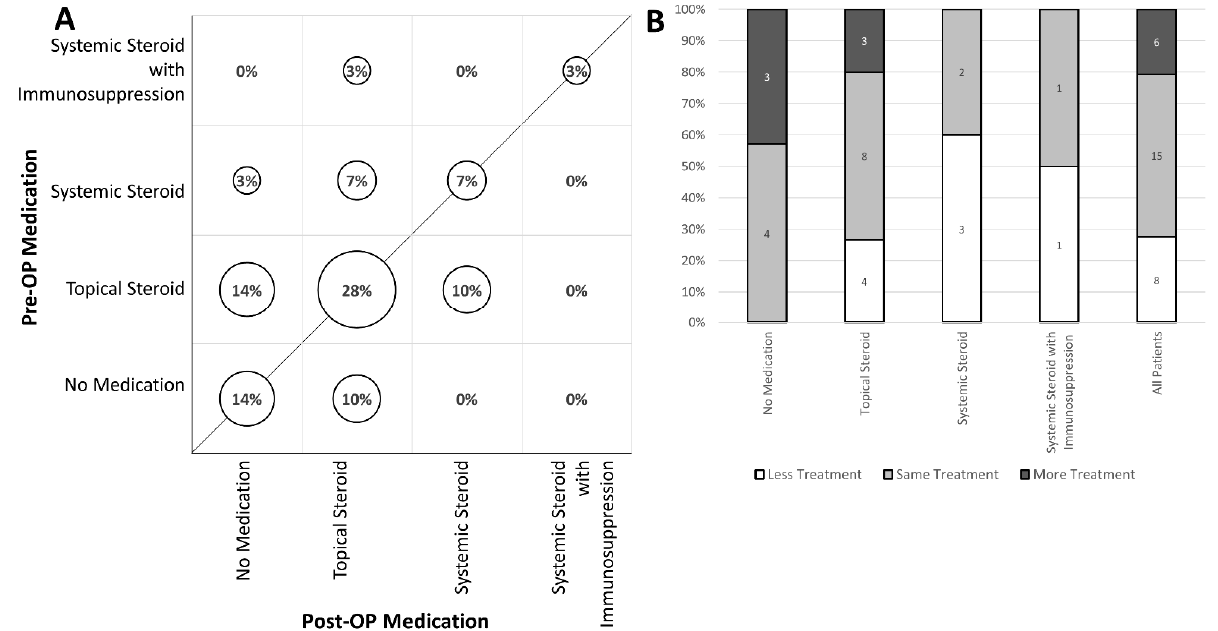
Figure 4. Comparison of Pre- and Post-ERM Surgery Uveitis Medication. ( A ) Bubble plot of medication for all patients. The size of each circle is proportional to the total number of observations and the labels are the percentage of eyes. Above the line represent patients with reduced medication regime post operatively. McNemar-Bowker test p = 0.673. ( B ) Overall, 52% of patients were on the same treatment class, 28% had less treatment, and 21% had their treatment increased.